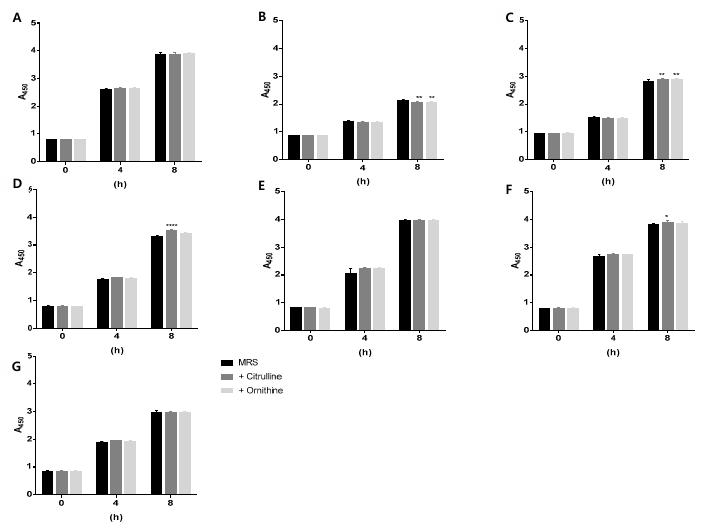
Figure 4. Effects of added arginine, citrulline, and ornithine on the growth of lactic acid bacteria. Bacterial growth with the addition of 1.5 mM citrulline and ornithine was monitored by performing WST-8 colorimetric assays. After a 4 or 8 h incubation at 30 °C, the absorbance of the samples in the presence of the WST-8 was measured at 450 nm. ( A ) L. brevis ; ( B ) P. pentosaceus ; ( C ) L. plantarum ; ( D ) L. lactis ; ( E ) L. sakei ; ( F ) L. mesenteroides ; ( G ) W. confusa . Here, * p < 0.05, ** p < 0.01, **** p <